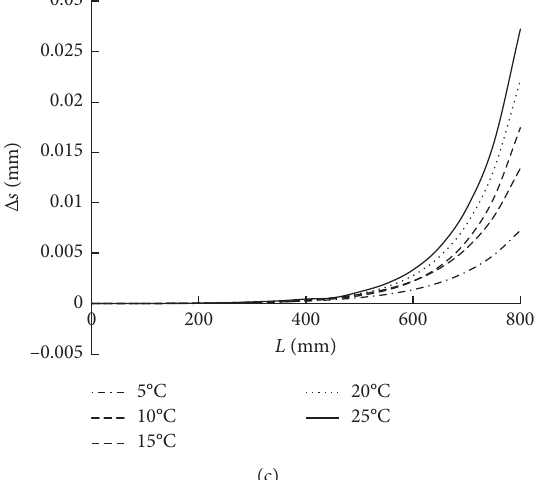
Figure 8: The effect of temperature on the interface slip. (a) Uniform load. (b) Symmetrical concentrated load. (c) Midspan concentrated load.